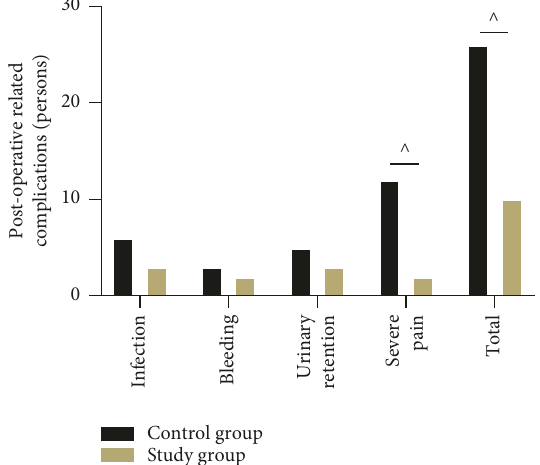
Figure 6: Comparison of postoperative complications within the two groups (persons). ^ represents a significant difference between the two